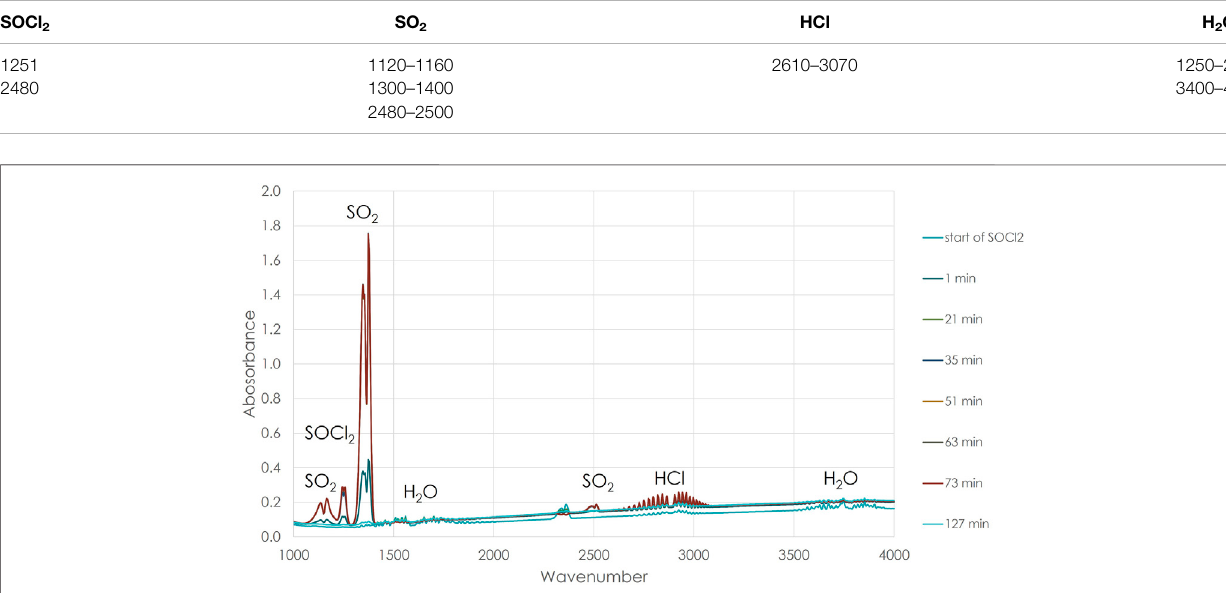
FIGURE 3 | Overlayed FTIR spectra showing the increased production of SO 2 over time — the units in the legend are minutes after the SOCl 2 was valved into the system. Increases were also observed in the HCl peak but were smaller than those for SO 2 .